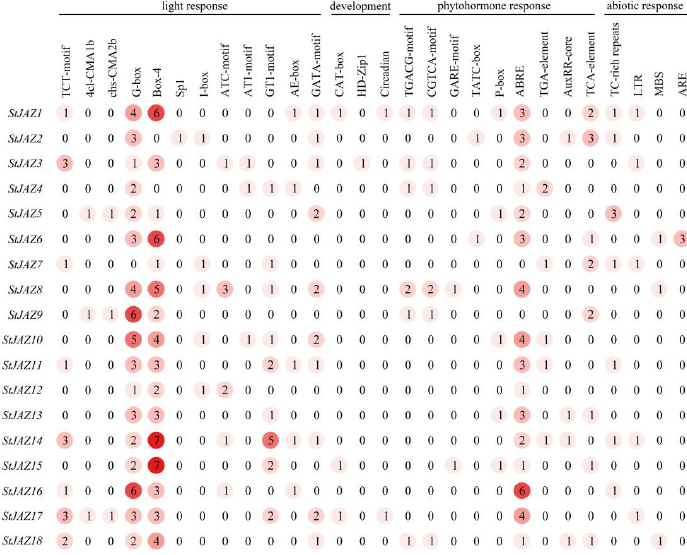
Figure 4. StJAZ genes promoter cis-acting elements. The different colors and numbers in the circle represent the number of cis-acting elements in the promoter area of the StJAZs. As the number in the circle increases, the color of the circle becomes darker.